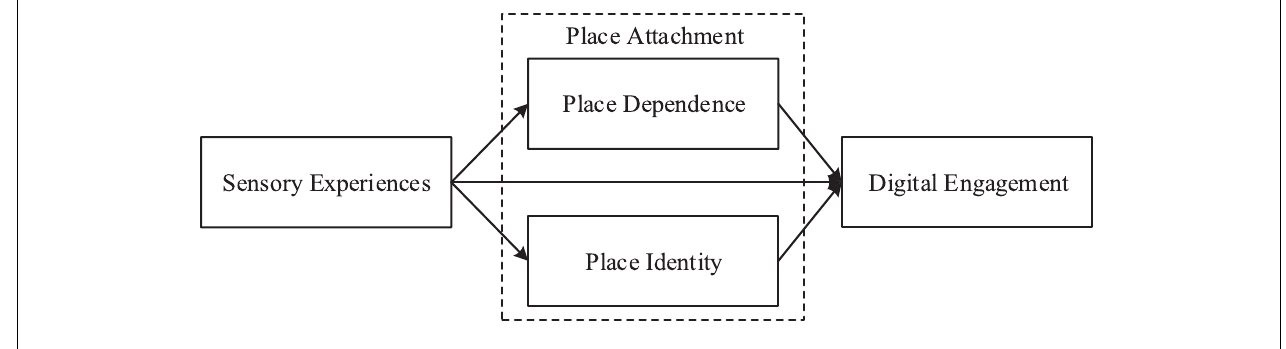
FIGURE 1 | Conceptual